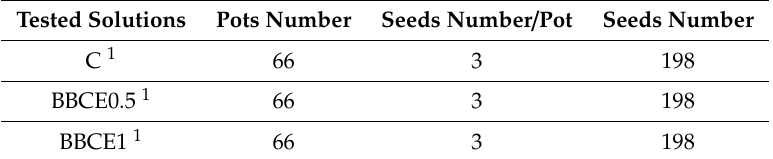
Table 1. Experimental plan for sowing sage ( Salvia o ffi cinalis L.) seeds. Tested Solutions Pots Number Seeds Number /